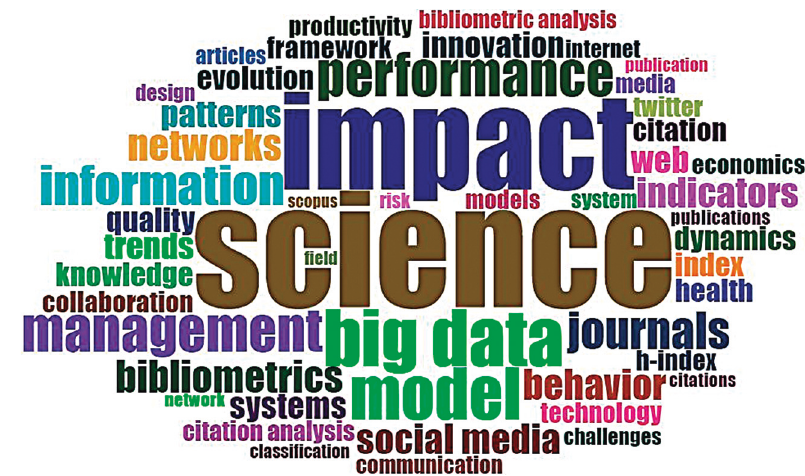
Figure 7: Word cloud in computational social